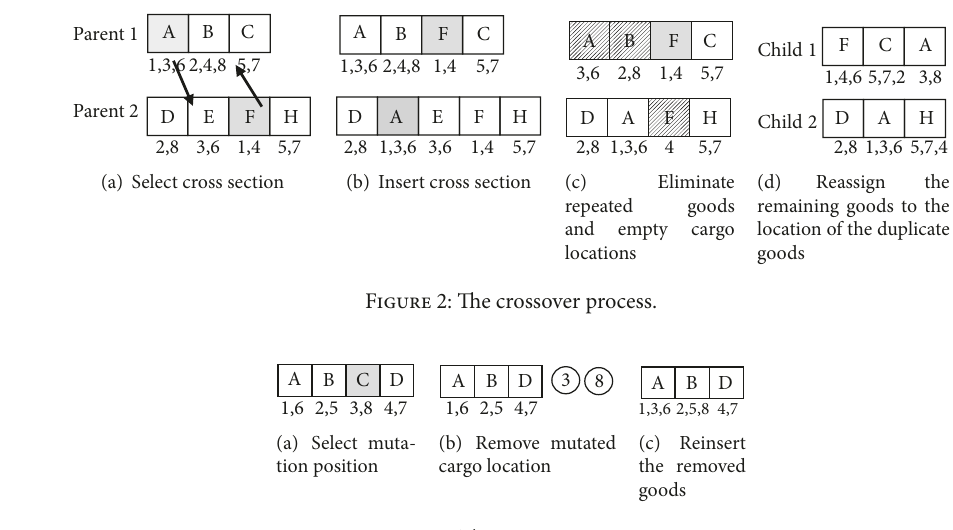
Figure 3: The variation